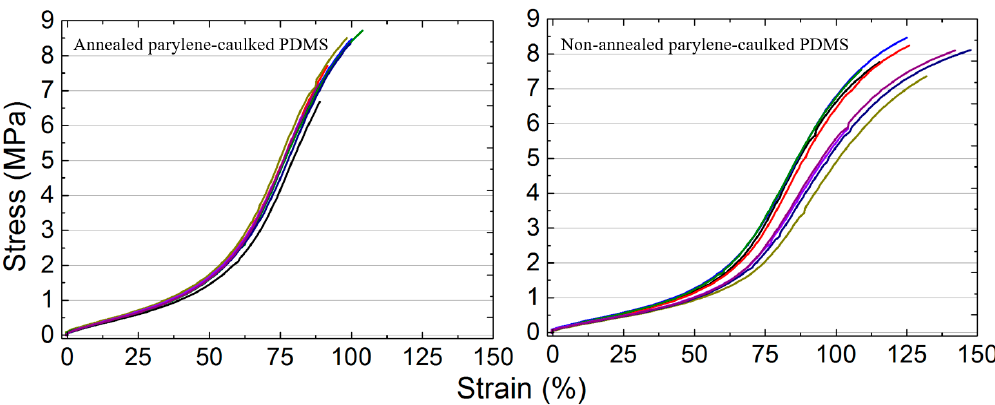
Figure 2. Strain-stress curves of annealed ( Left ) and non-annealed parylene-caulked PDMS ( Right ). The eight lines in different colors represent the strain-stress curves of eight different specimens.